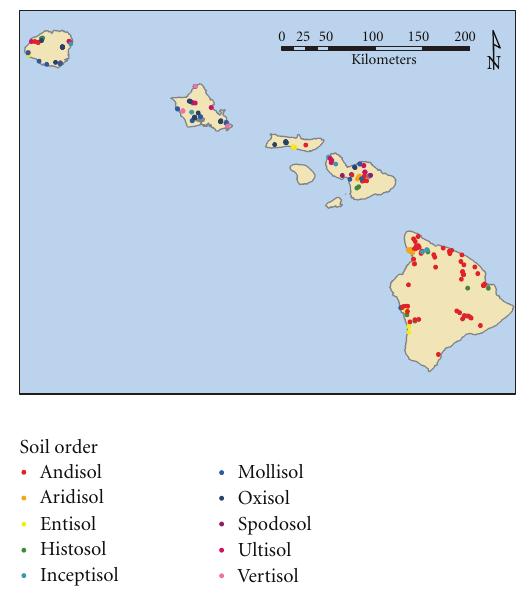
Figure 1: Distribution of soils sample collection sites throughout the Hawaiian Islands with symbol color indicating soil